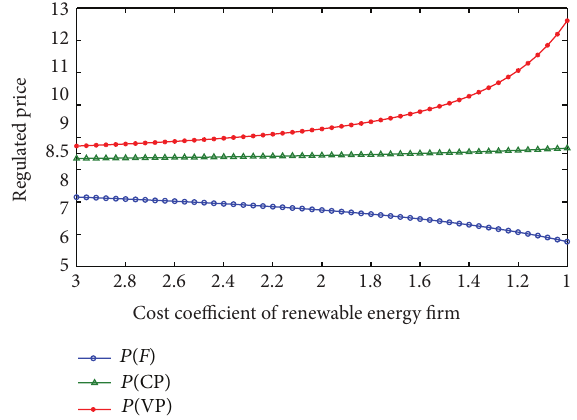
Figure 5: Three tools comparison on regulated price under the change of cost coefficient of renewable energy Firm 𝑐 𝑅